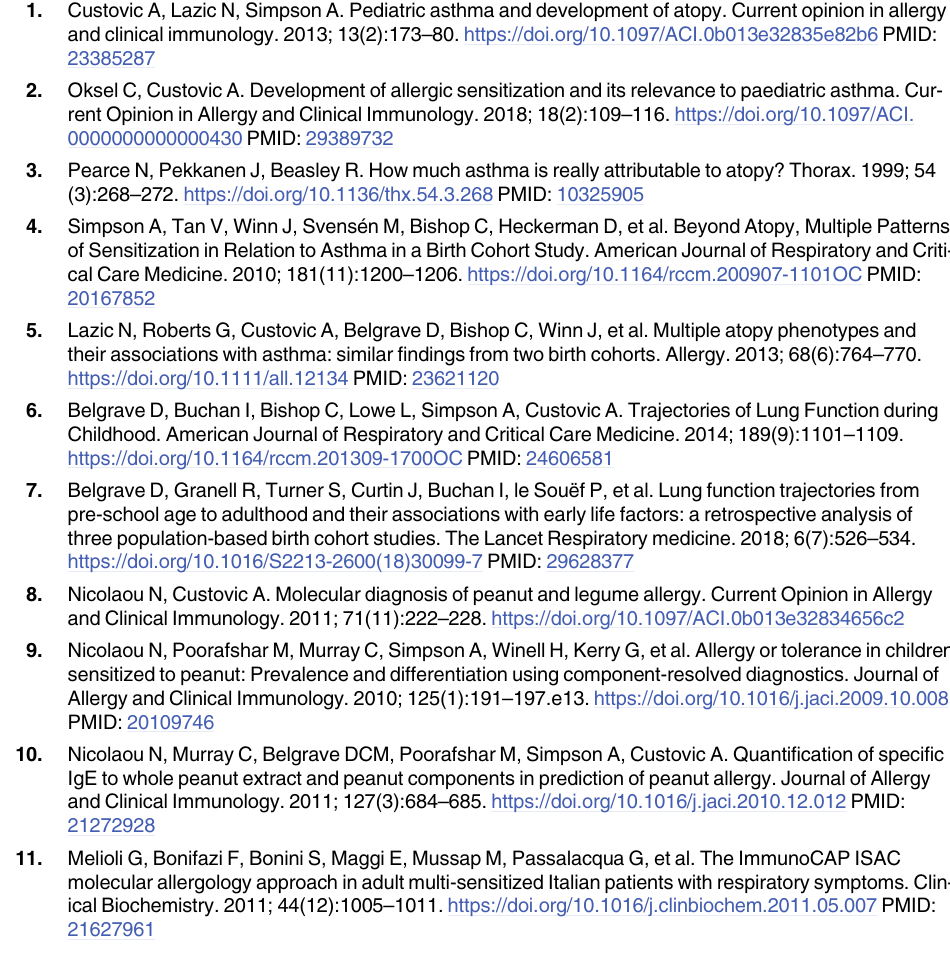
S6 Fig. Flowchart of participants in both primary analysis and